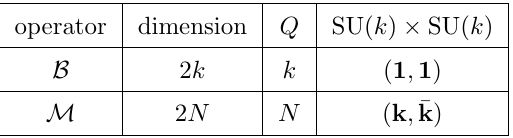
Table 1 . Spectrum of charged BPS operators in the uniform quiver.